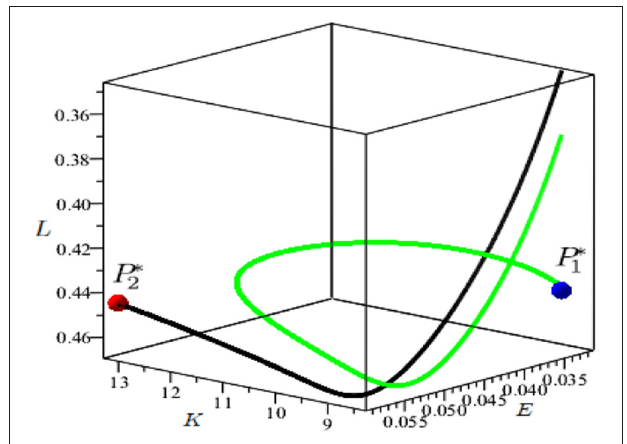
FIGURE 14 | Parameter set: α = 0.1, β = 0.8, γ = 0.58, δ = 0.05, ǫ = 1, η = 1.5, θ = 0.001, E = 0.17. Global indeterminacy in the space ( E , K , L ). The trajectory in green approaches the sink P * 1 (depicted in blue) starting from the point ( E * 1 , K * 1 , L 1 0 = 0.3745910588598), while the trajectory in black, approaching the saddle P * 2 (depicted in red), starts from the point ( E * 1 , K * 1 , L 2 0 =